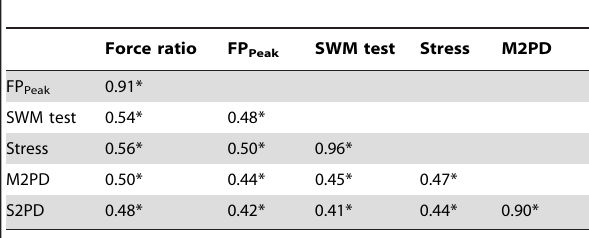
Table 2. Correlation of traditional hand sensibility tests and parameters of pinch force adjustment in PHUA test for CTS patients.